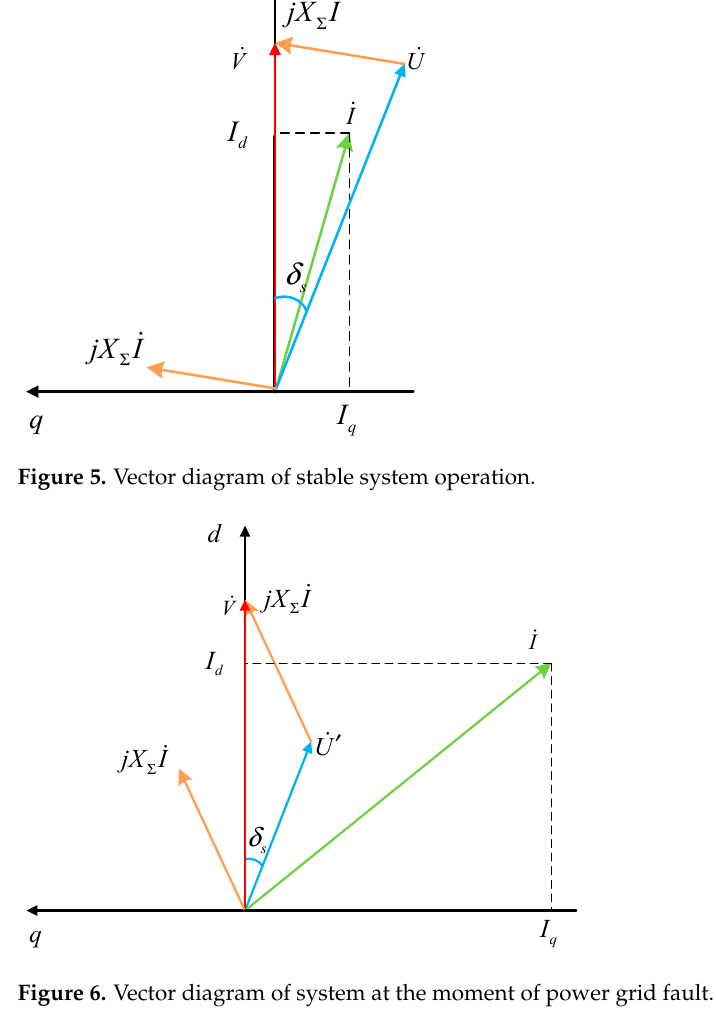
Figure 6. Vector diagram of system at the moment of power grid fault.